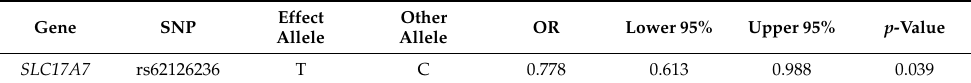
Table 3. Odds ratios calculated for polymorphisms of the studied genes associated with the predomi- nant symptoms of schizophrenia (negative or positive).